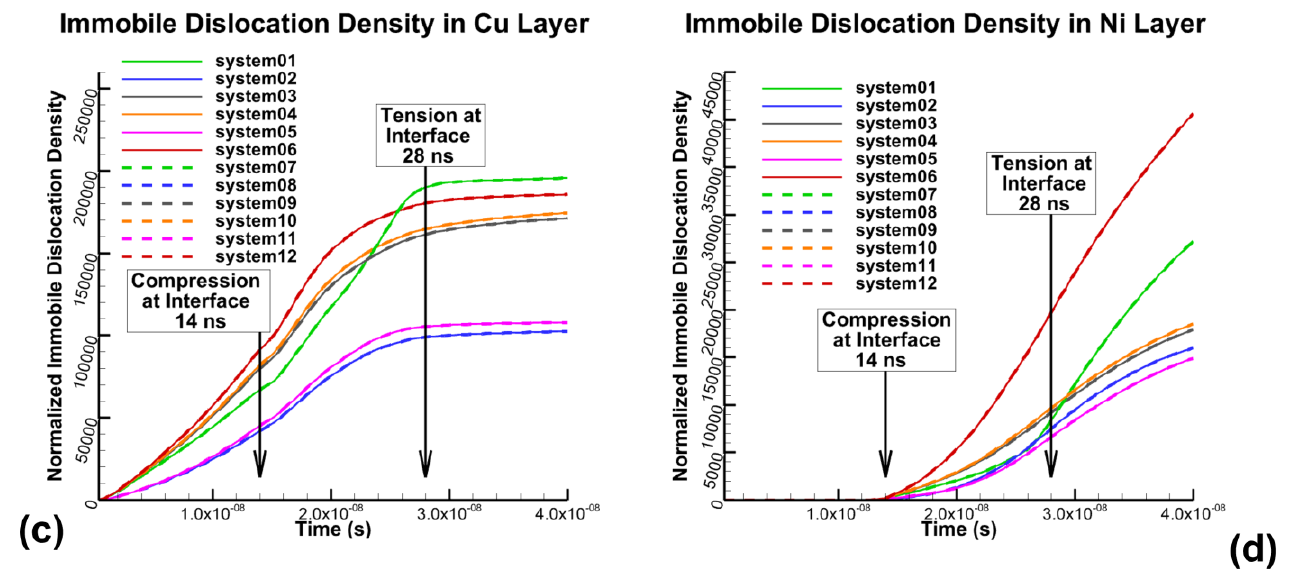
Figure 7. ( a ) Normal stress at a nominal strain of 2.5% at 14 nanoseconds, and ( b ) 28 nanoseconds. ( c ) normalized immobile dislocation densities in the copper layer, and ( d ) the nickel layer. At 14 nanoseconds, normal stresses are mostly compressive at the interface, at 28 nanoseconds normal stresses transition to tensile at the interface. The slip systems are given in Table 1.